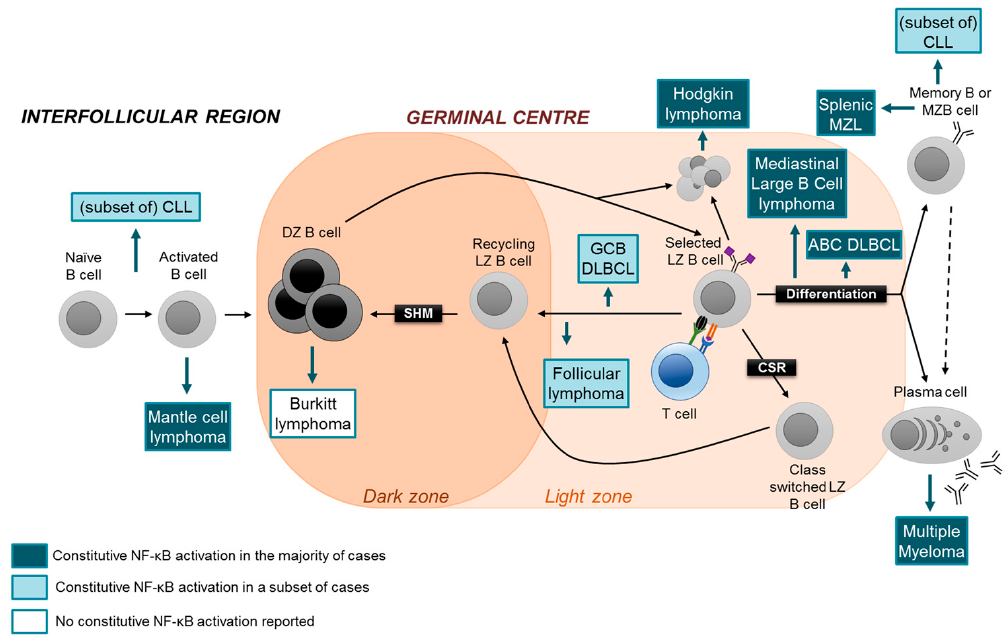
Figure 3. GC B-cell development and cellular derivation of B-lineage malignancies. Whereas Burkitt lymphoma seems to originate from the transformation of dark zone cells, recent evidence suggests that follicular lymphoma and germinal center B-cell type (GCB)-DLBCL may derive from the transformation of light zone cells (see text). Activated B-cell type (ABC)-DLBCL is thought to originate from light zone cells poised to undergo PC differentiation. Conventional mantle cell lymphoma (MCL) may derive from the oncogenic transformation of an antigen-activated pre-GC B cells. Multiple myeloma is a tumor of bona fide PCs. Hodgkin lymphoma is thought to originate from light zone B cells with “crippled” antigen receptors, mediastinal large B-cell lymphoma from a differentiation light zone B cell, and MZL from a post-GC marginal zone/memory B cell. Chronic lymphocytic leukemia (CLL) can have unmutated and mutated IgV genes. Several mature B-lineage malignancies show constitutive NF- κ B activity, as indicated.